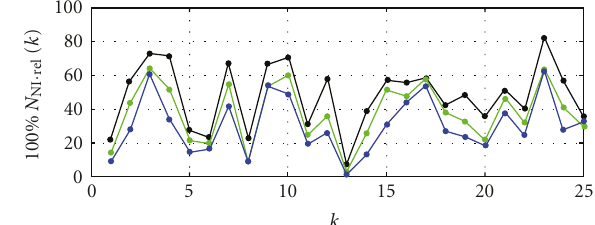
Figure 6: The number of NI SWs, N NI · rel versus image index k for the TID2008 database for noise variance σ 2 (red curve) and 130 (black curve).